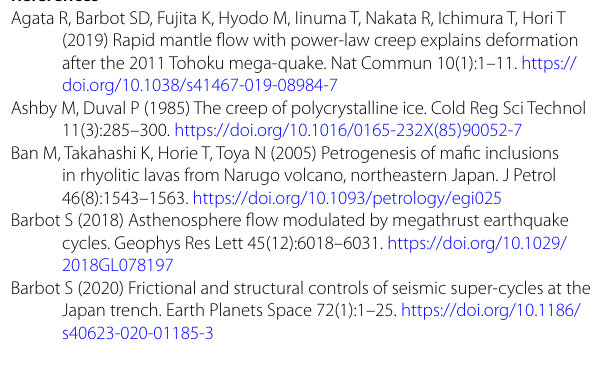
Table S2 . Depth-dependent viscosity models for mantle wedge. Table S3 . Depth-dependent viscosity models for oceanic mantle. Table S4 . Param- eters for LVZ